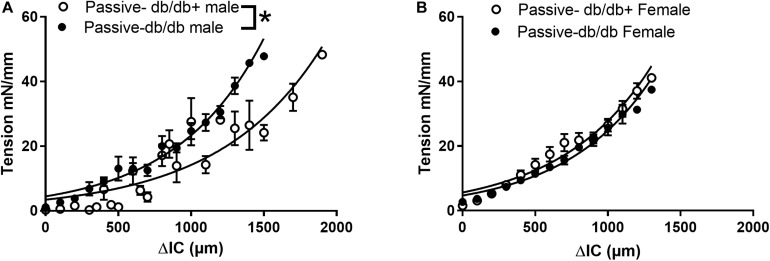
Passive and active properties of aorta segments from male and female diabetic db/db and normoglycaemic db/db+ mice. Aorta segments were mounted in myographs for isometric tension measurements allowing us to also evaluate the active vascular smooth muscle component. (A) Passive stretch of aorta segments measured as increase in internal circumference (ΔIC) against increase in force (ΔF) from male db/db (n = 6) and db/db+ mice (n = 6). (B) The passive stretch of aorta segments measured as an increase in internal circumference (ΔIC) against an increase in force (ΔF) from female diabetic db/db (n = 6) and control db/db+ mice (n = 6). The results are means ± SEM, *P < 0.05, db/db versus db/db+ controls.